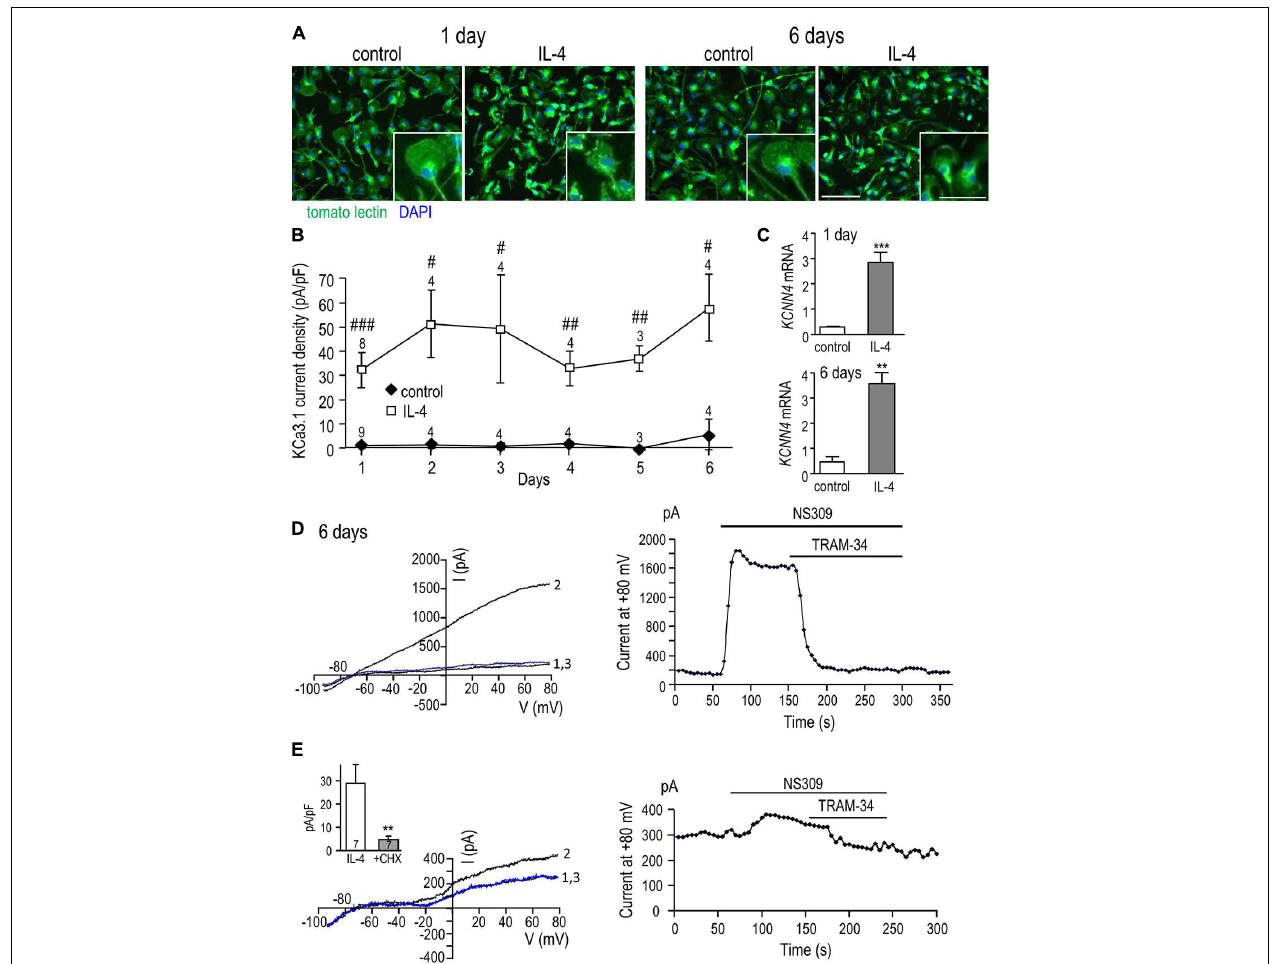
FIGURE 3 | KCa3.1 current by IL-4 remains elevated over time and requires de novo protein synthesis. (A) Effect of IL-4 treatment on microglial morphology. Primary rat microglia were treated with 20 ng/ml IL-4, fixed 1 or 6 days later, and stained with tomato lectin (green) to identify microglia and DAPI (blue) to label nuclei. Scale bars = 100 μ m (main images) and 50 μ m (insets). (B) Microglia were treated with 20